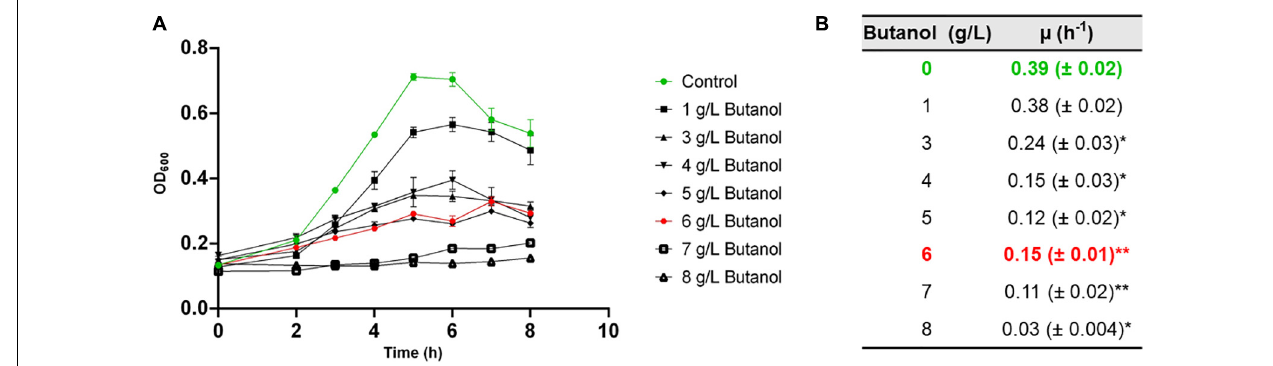
FIGURE 1 | Growth kinetics (A) and specific growth rate ( µ , B ) of C. cellulovorans grown in media supplemented with different butanol concentration. Bars represent standard errors. Data are the averages of three biological replicates. Asterisks indicate values that significantly ( * p < 0.05; ** p < 0.005) differ from that measured in the control condition (no added